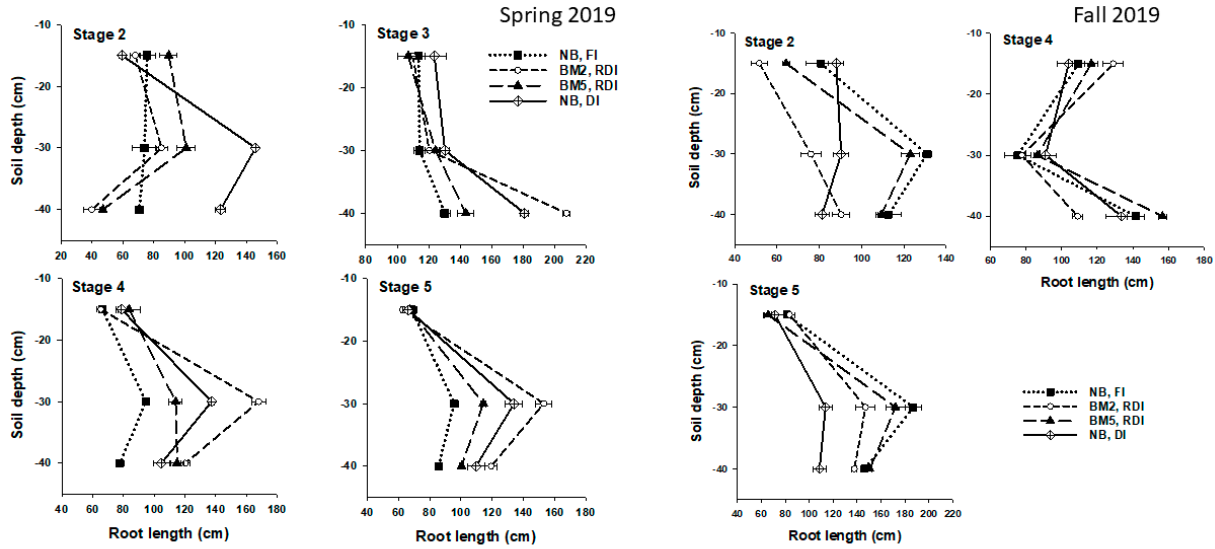
Figure 7. Effects of irrigation and N application timing on tomato root length during 2019 growing seasons in Immokalee, Florida. (BM = 25% pre-plant with 75% fertigation, NB = zero pre-plant with 100% fertigation. FI = full irrigation at 100% ETc, DI = deficit irrigation at 66% ETc and RDI = regulated deficit irrigation at 66% ETc, 0–4 weeks after transplanting and 100% ETc from week 5). Error bars = 1 standard error.